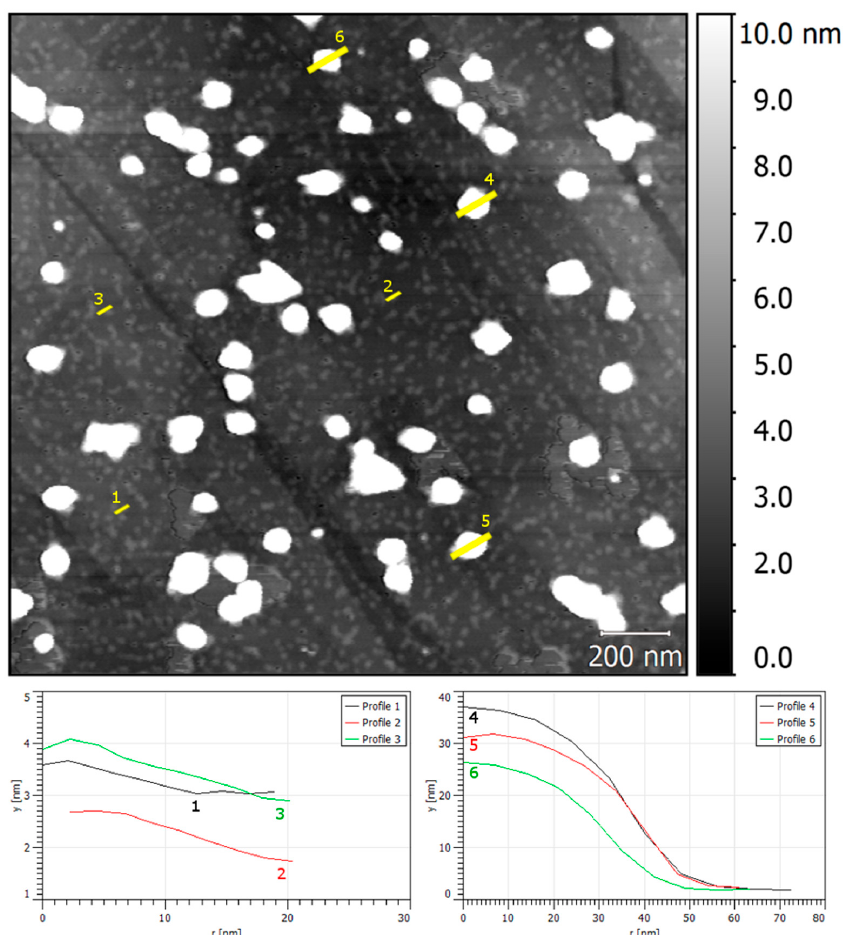
Figure 8. AFM of a sample electrodeposited at − 0.5 V vs. Ag/AgCl in 3 mM H 2 PtCl 6 , 0.5 M NaCl,